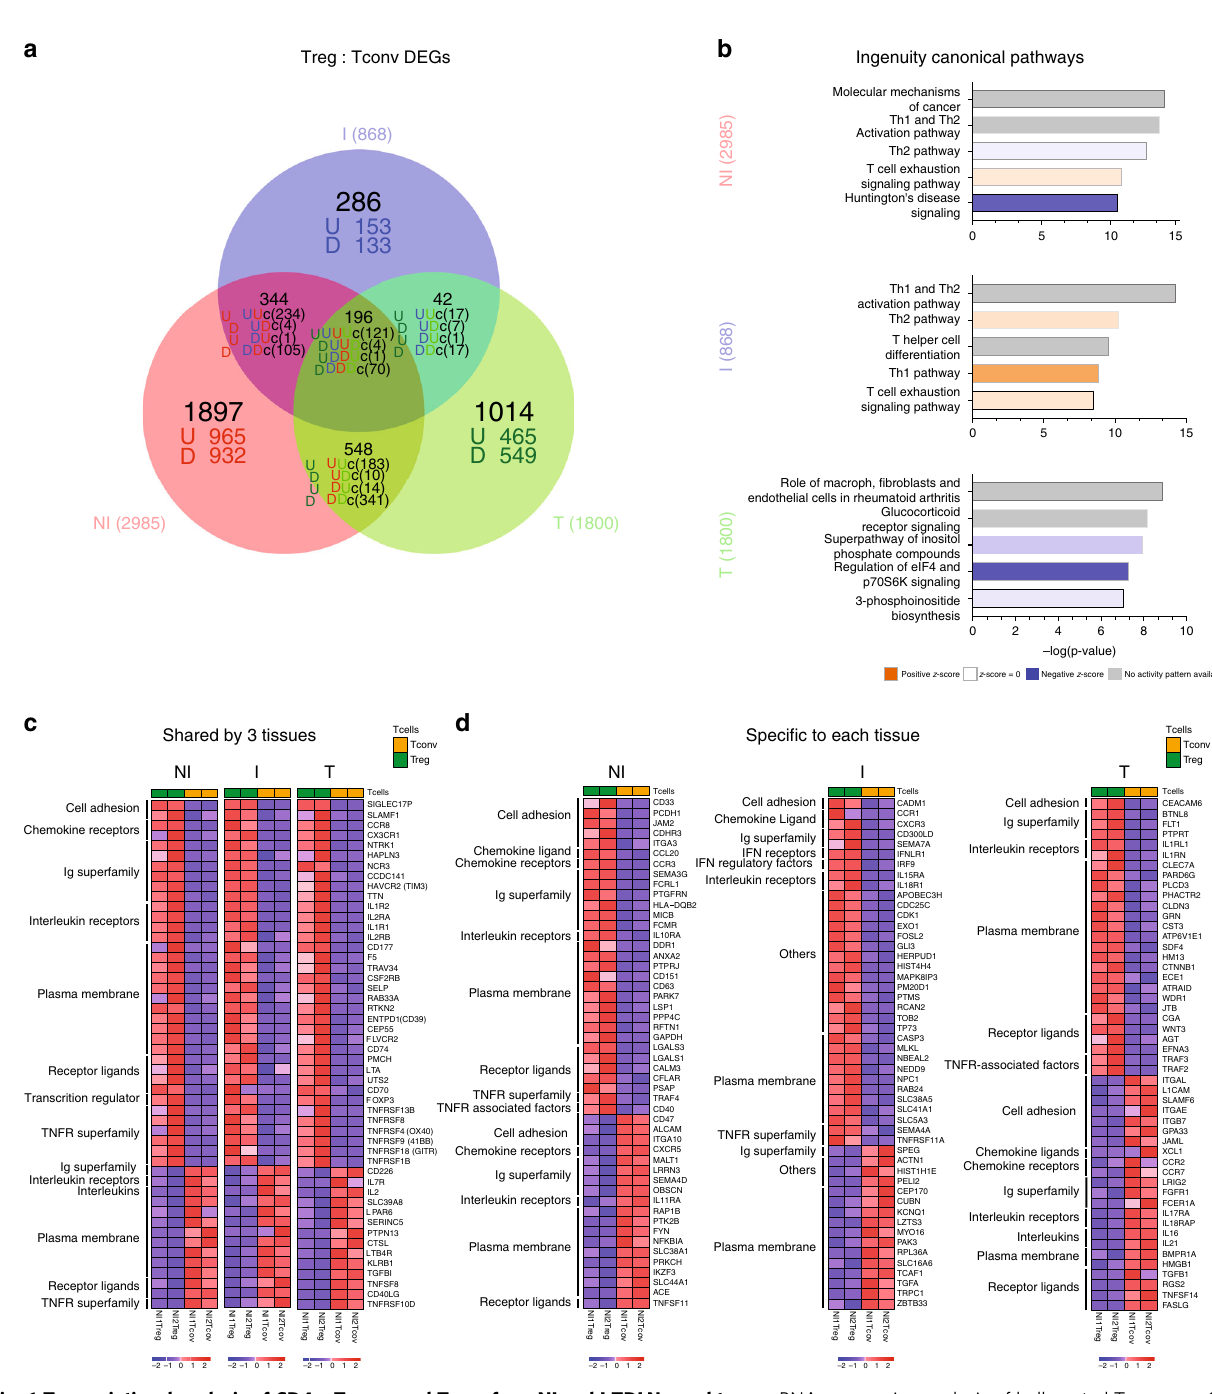
Fig. 6 Transcriptional analysis of CD4 + Tconvs and Tregs from NI and I TDLNs, and tumor. RNA-sequencing analysis of bulk sorted T-memory CD4 + Tconvs and Tregs from matched NI and I TDLNs and the primary tumor. a Venn diagram and b pathway analysis of differentially expressed genes (DEG, fold change 1.2, p < 0.05) between Tregs and Tconvs in NI TDLNs, I TDLNs and tumors. c , d Heatmaps showing 50 DEGs common to Treg and Tconvs from the three tissues c or speci fi c to each tissue d . Red and blue indicate higher and lower expression, respectively. Family gene names are indicated (left). Cell adhesion: cell adhesion molecules. Ig superfamily: immunoglobulin superfamily domain containing. TNFR receptor superfamily: tumor necrosis factor receptor superfamily. TNFR-associated factors: tumor necrosis factor receptor-associated factors. IFN receptors: interferon receptors. IFN regulatory factors: interferon regulatory